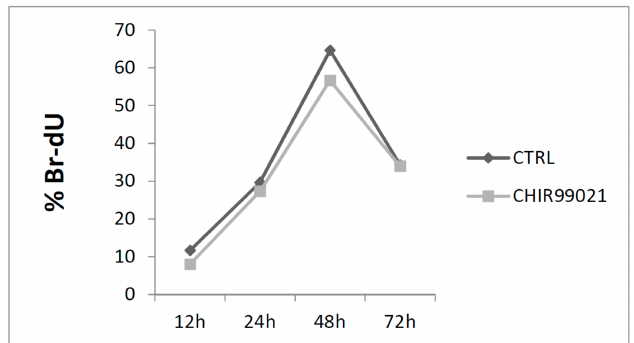
Figure 2. MLO-Y4 cells were treated with CHIR99021 at 100 nM for 12, 24, 48, and 72 h. BrdU staining was evaluated by Fluorescence-Activated Cell Sorter (FACS). Error bars represent ± ST.DEV (Standard Deviation).